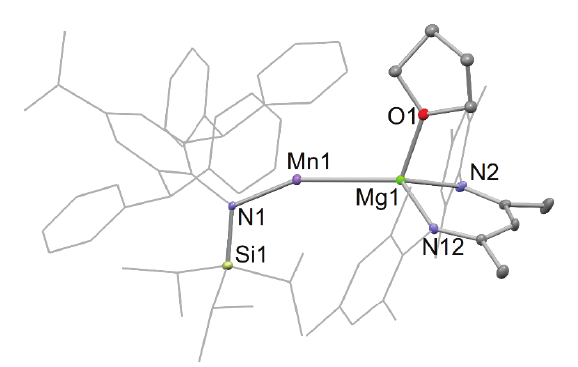
Figure 1: Thermal ellipsoid plot (20% probability surface) of the molecular structure of 2 (hydrogen atoms omitted; Ar † , Mes and isopropyl groups shown as wireframe for clarity). Selected bond lengths (Å) and angles (°): Mn(1)–N(1) 2.039(5), Mn(1)–Mg(1) 2.921(2), Mg(1)–N(2) 2.075(5), Mg(1)–N(12) 2.082(5),